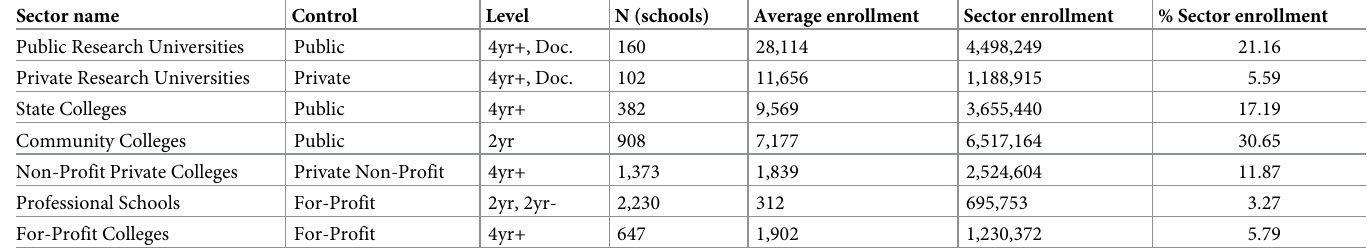
Table 1. Description of sectors and their descriptive statistics. Here we address the basic characteristics of the named sectors used for our analysis. It should be noted that “Doc.” indicates that the school grants research doctoral degrees.